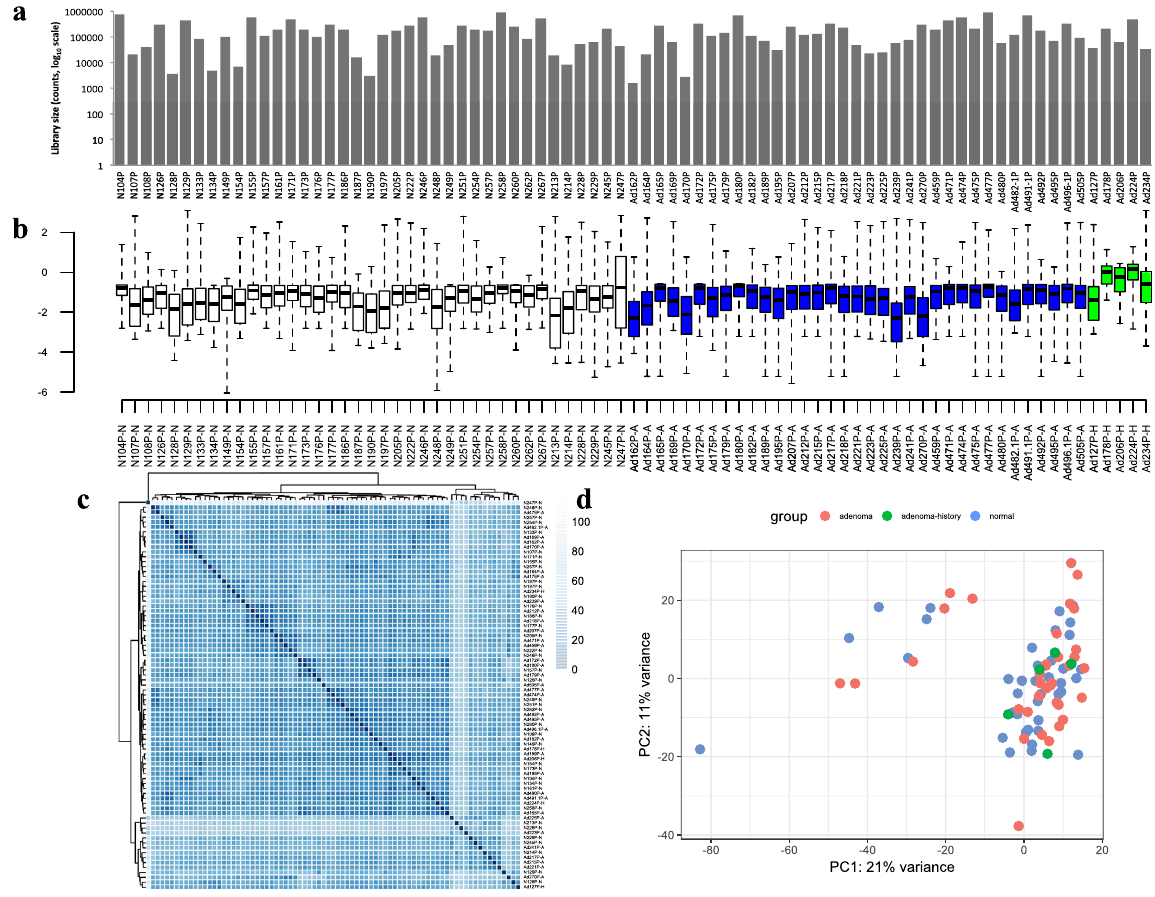
Figure 2. Overview of sequencing data. (a) Library size of each sample was showed as log 10 scale. (b) Cook’s distance of adenoma and adenoma with malignant history samples was highlighted in blue and green color, respectively. Sample distances visualized by (c) clustering based on Euclidean distance and (d) PCA showed that plasma samples were not distinct based on their group labels. “N”, “A” and “H” labels of sample name indicate normal, adenoma and adenoma with cancer history groups, respectively.